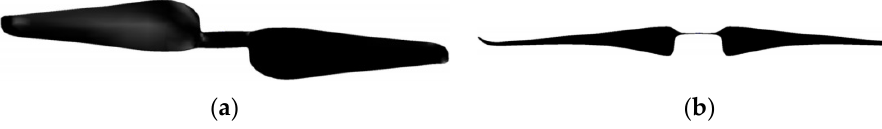
Figure 4. Propeller model. ( a ) Top view; ( b ) Front view.